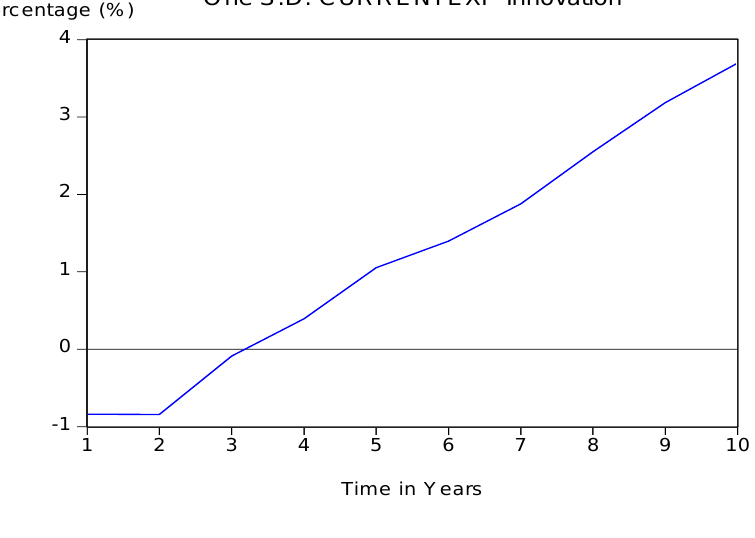
Fig. 4. Accumulated response of the growth rate of non-oil real GDP to current expenditure